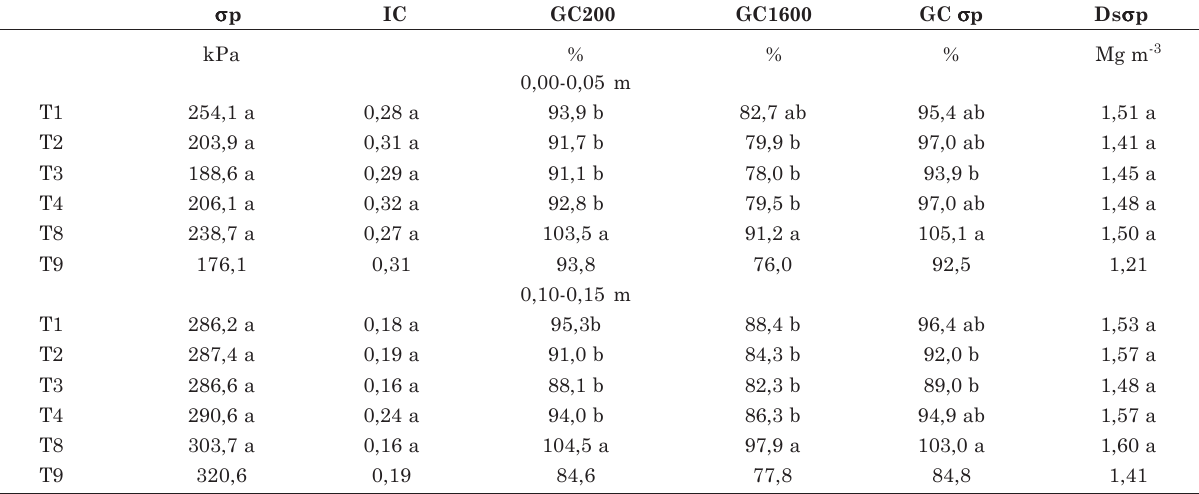
T1: solo construído sob Capim Vaquero; T2: solo construído sob Brizanta; T3: solo construído sob Tanzânia; T4: solo construído sob Humidícola; T8: solo construído sem plantas de cobertura; e T9: solo natural sob vegetação nativa. Médias seguidas pela mesma letra minúscula nas colunas, dentro de cada variável e camada de solo, não diferem significativamente pelo teste de Duncan a 5 %.